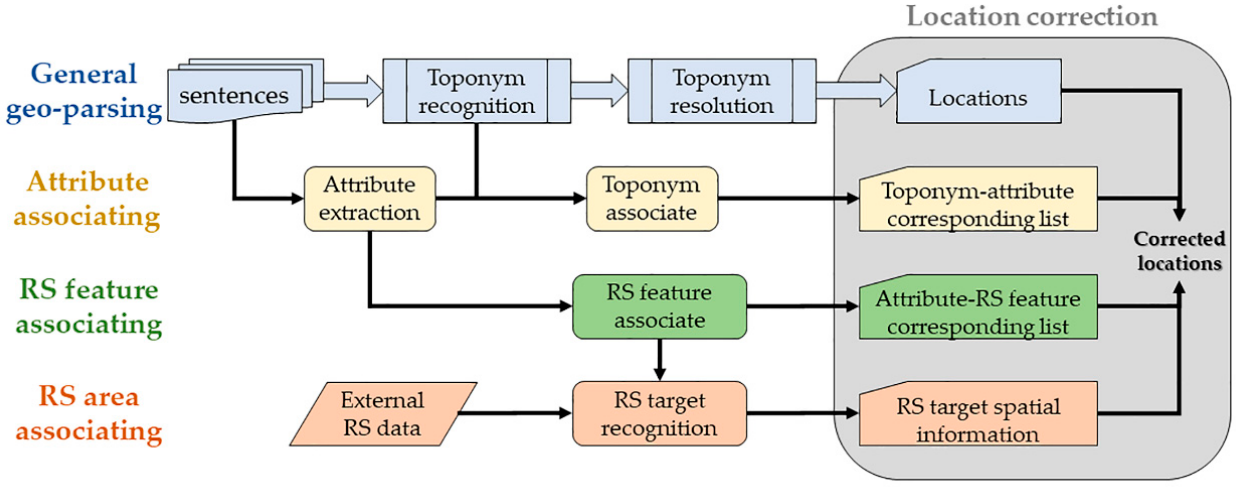
Figure 3. Basic idea of toponym correction based on remote sensing images.